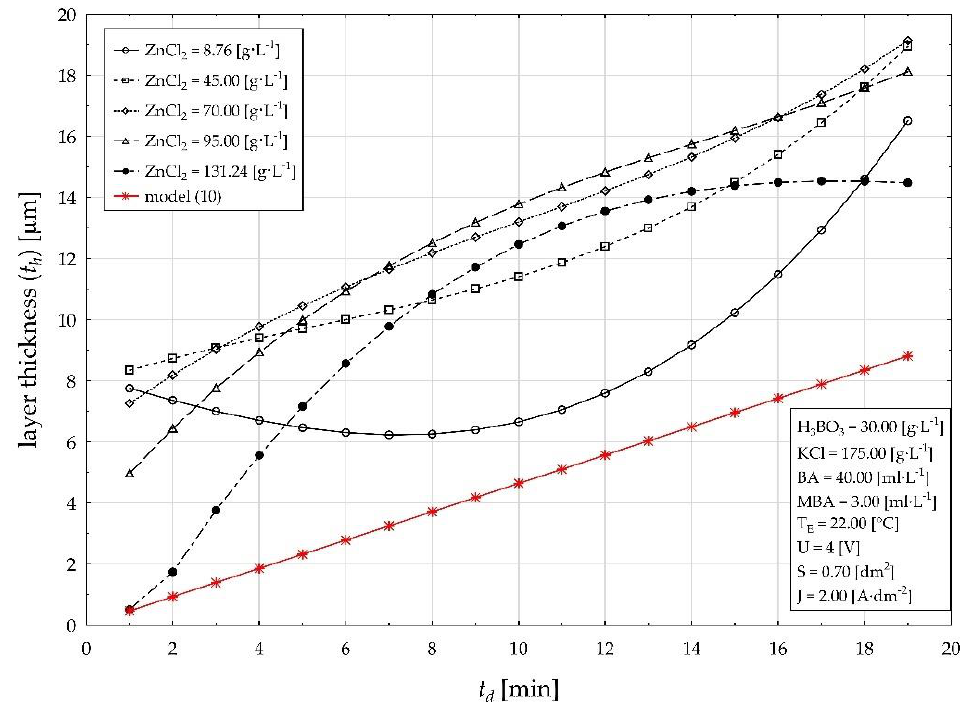
Figure 2. Graphical representation of the thickness of the resulting zinc coating formed during acid zinc plating for theoretical model (6)—plotted in red color; and for developed nonlinear regression model (16).